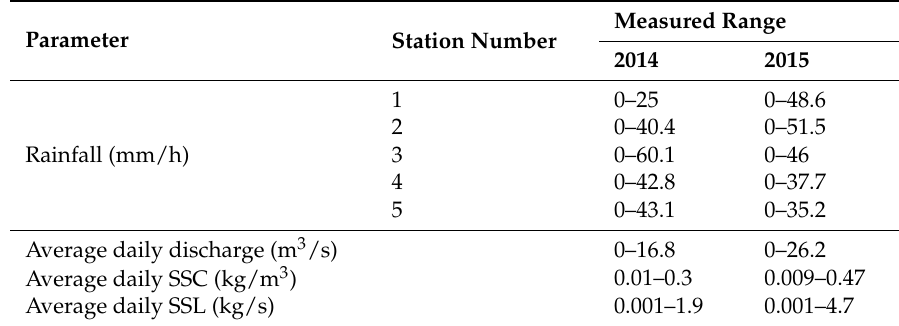
Table 3. Range of the measured parameters for the years 2014 and 2015. SSC refers to suspended sediment concentration and SSL to suspended sediment